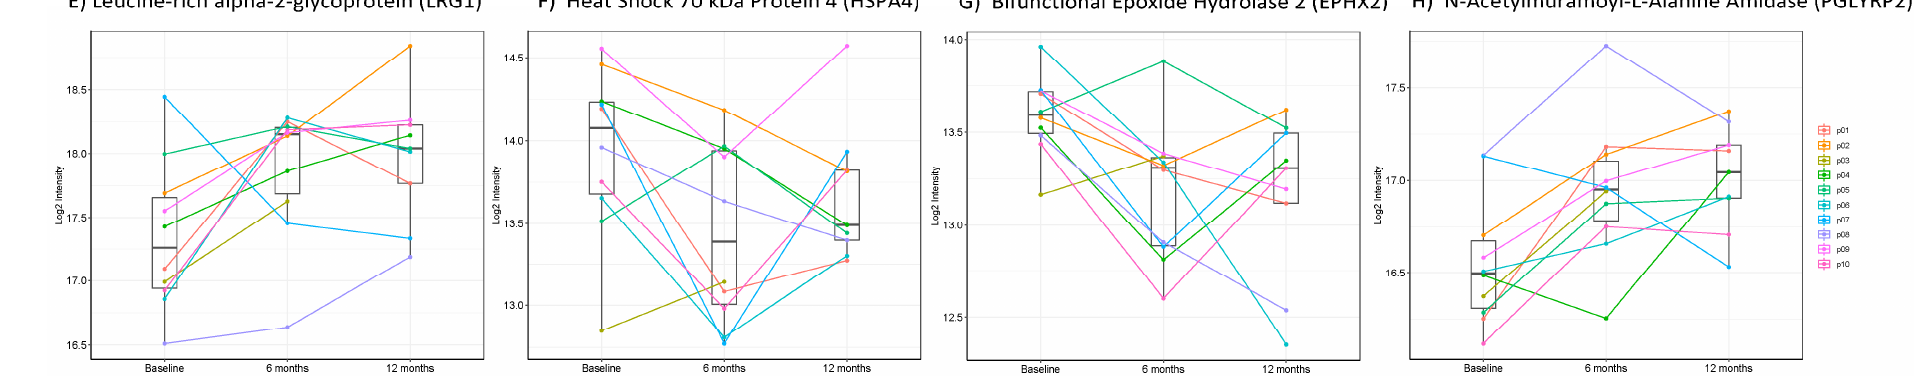
Figure 4. ( A – H ): Changes in protein expression between baseline, 6 months and 12 months for the 8 differentially expressed proteins at both 6 months and 12 months post-surgery.